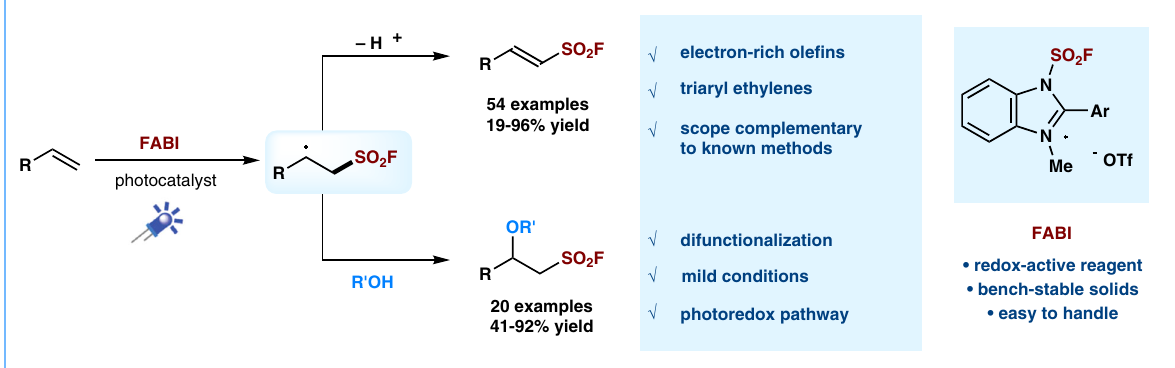
Fig. 2 The development of photoredox catalytic radical fl uorosulfonylation of ole fi ns. a The development of radical alkoxy- fl uorosulfonylation of styrene with alcohol as a nuleophile. b Radical fl uorosulfonylation of alkenes via radical chain pathway (Path I) versus photoredox pathway (Path II). c This work: photoredox catalytic radical fl uorosulfonylation of ole fi ns enabled by redox-active radical reagent